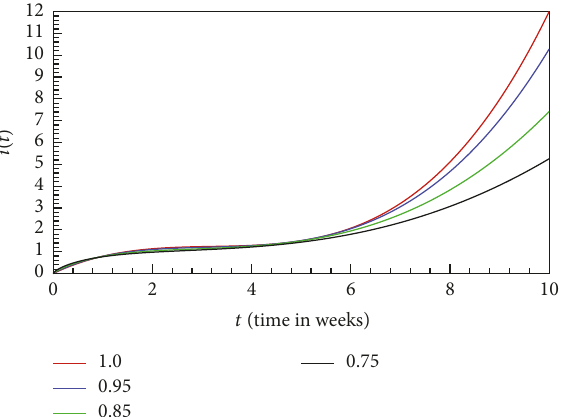
Figure 2: Plot of approximate solutions of infected class (𝑖) corresponding to different fractional values of 𝛼 𝑘 for 𝑘 = 1, 2,3 .